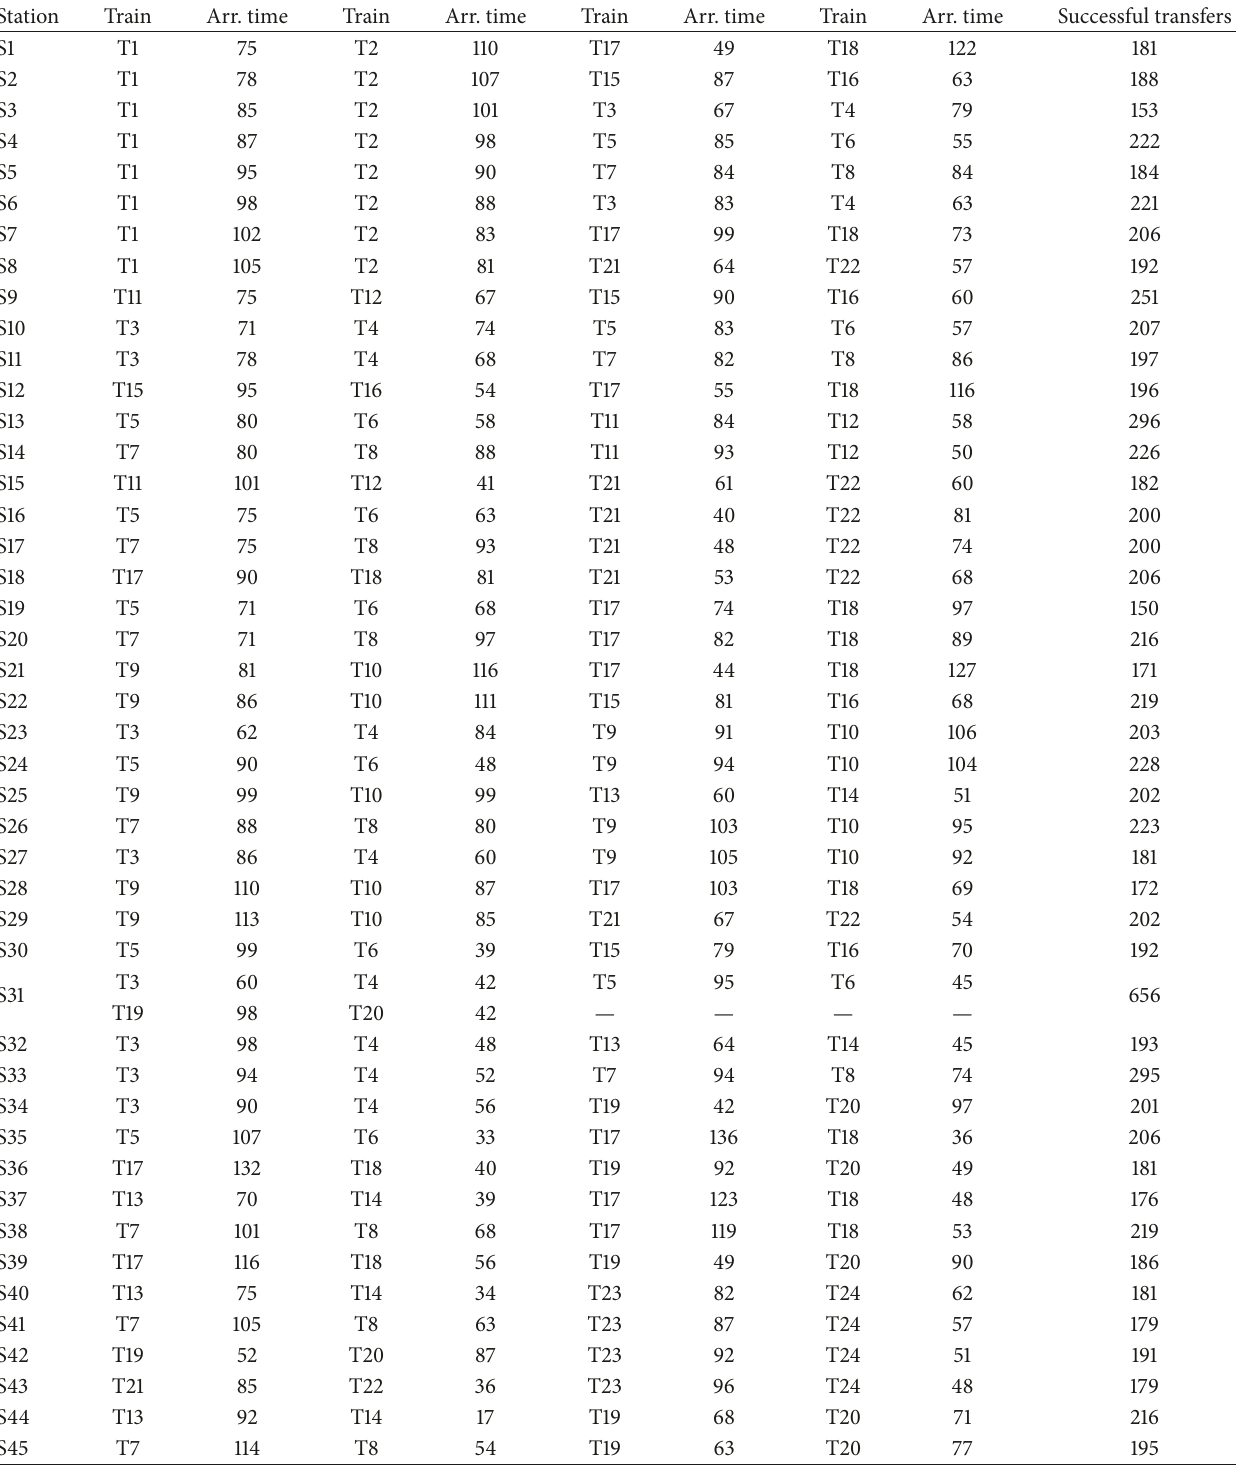
Table 2: Transfer-station arriving time of last trains and successful transfers in Beijing subway